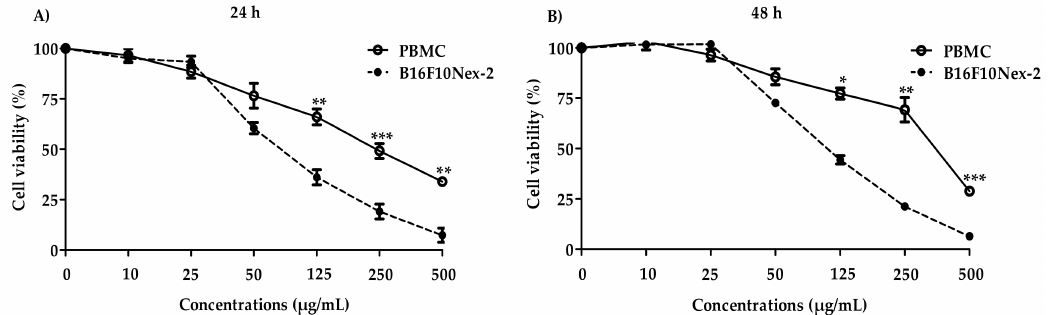
Figure 6. Viability curve in PBMC and B16F10Nex-2 cells. Cells were treated with different concentrations of the SAAE for ( A ) 24 h or ( B ) 48 h. Data are expressed as the mean ± SEM ( n = 3) in triplicates. * p < 0.05, ** p < 0.01, and *** p < 0.0001 compared with B16F10Nex-2